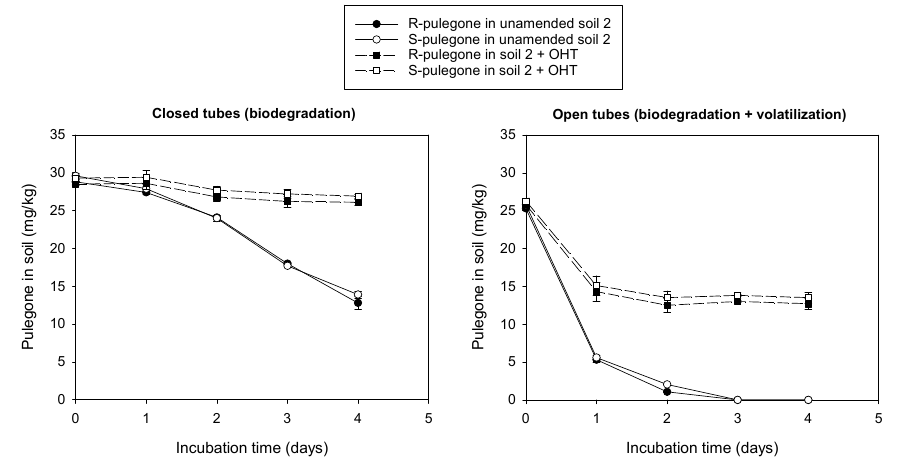
Figure 5. Dissipation curves of R- and S-pulegone in unamended and OHT-amended soil 2, measured in closed and open tubes. Error bars correspond to the standard errors of triplicate measurements.